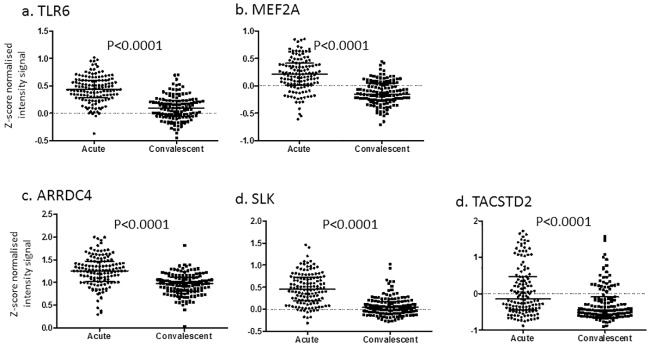
Paired acute and convalescent whole blood gene expression levels for 131 KD subjects for the six genes implicated in KD susceptibility.P values are uncorrected. Transcript levels from microarray database as previously described, not corrected for cell number [29]. Abbrv.: TLR6: Toll-like receptor 6; MEF2A: myocyte enhancer factor 2A; ARRDC4:arrestin domain containing 4; SLK: STE20 like kinase; TACSTD2: tumor-associated calcium signal transducer 2.